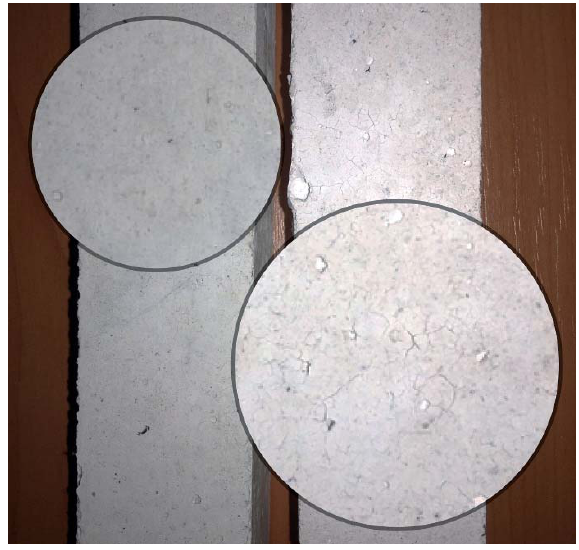
Figure 7. Surface of CCA ‐ AC ( left ) and CGA ‐ AC ( right ) samples after heating at 400 °C.